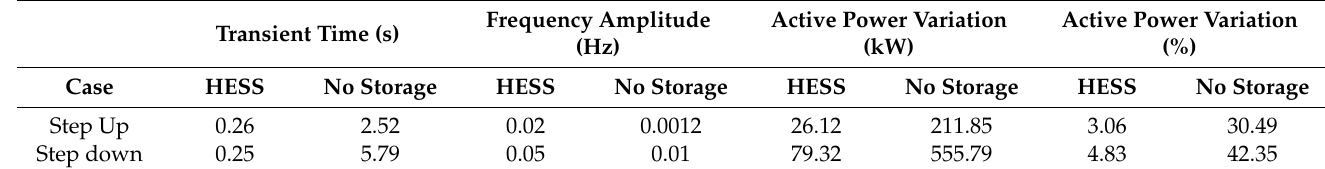
Figure 5. Active power exchanged with the grid at the PCC for the ( a ) step-up scenario and ( b ) step- down scenario, in the case of HESS presence (blue line) and absence (red line). Table 3. Main simulation